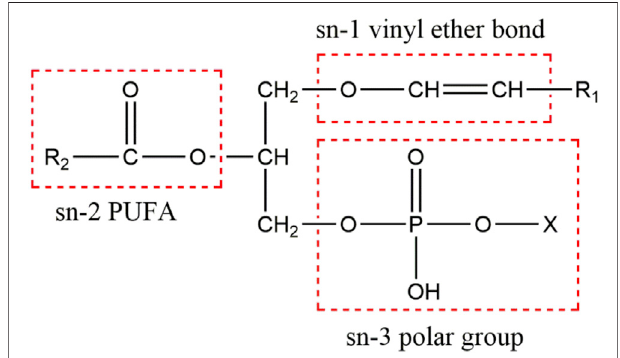
FIGURE 1 | The chemical structure of plasmalogens. Plasmalogen is characterized by a vinyl ether linkage with 16:0, 18:0, and 18:1 hydrocarbon chains at sn-1 position, an ester bond linking PUFAs at sn-2 position, and a phosphategroup atsn-3 position(Xdenotes ethanolamineorcholine)of the glycerol